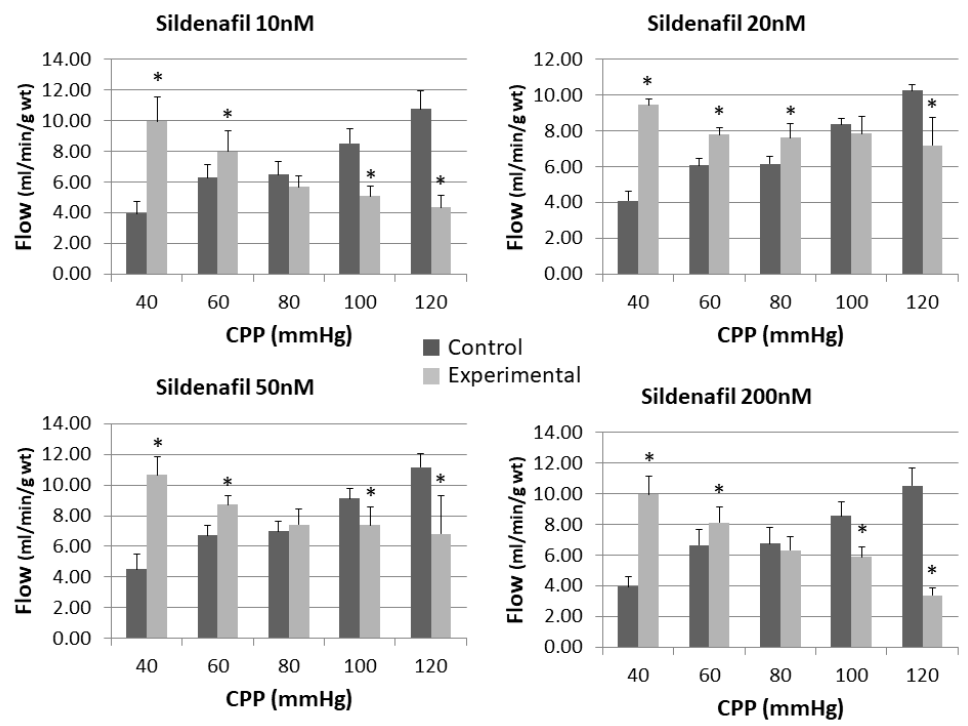
Figure 1. Influence of different sildenafil doses on the coronary flow of the isolated rat heart. * p < 0.05, Mixed between-within subject ANOVA; Tukey’s HSD.